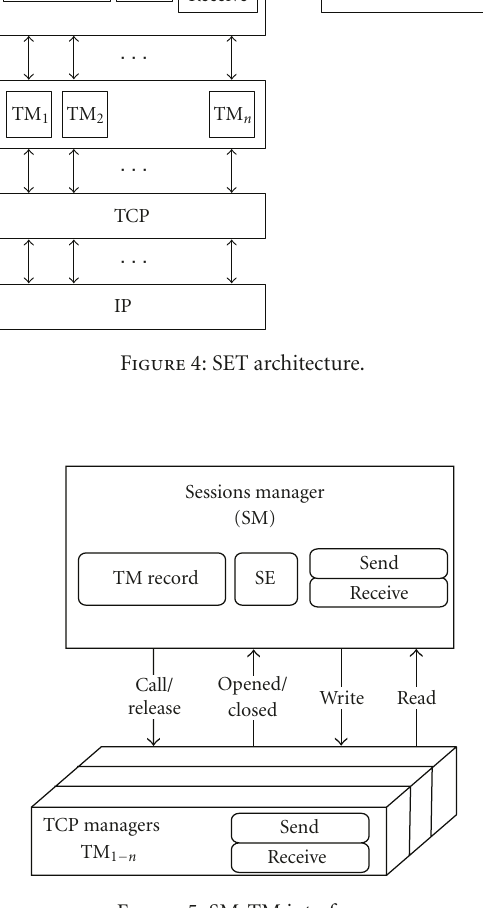
Figure 5: SM-TM interface.